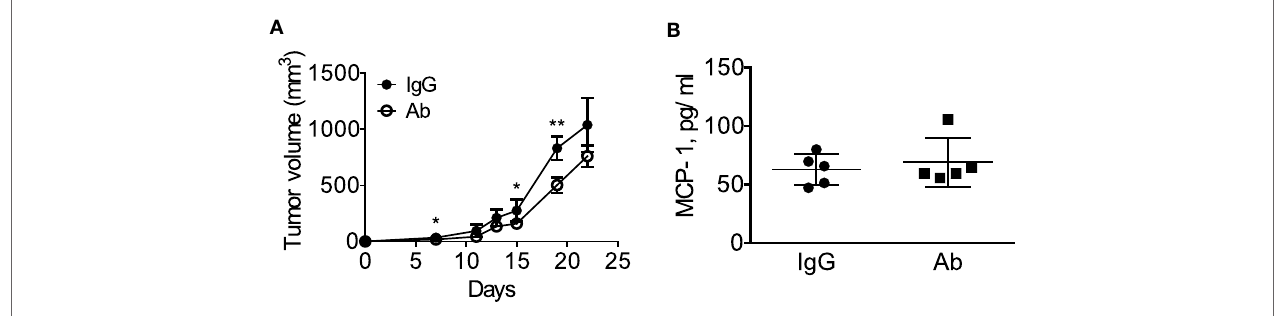
FigUre 7 | intratumoral injection of anti-gM-csF had a limited effect on tumor progression in 4T1 tumor-bearing mice. (a) 1 × 10 5 4T1 cells (100 μ l) were mixed with 10 μ g of normal rat IgG or anti-GM–CSF IgG and injected into the second mammary pad of WT mice. Mice were then received intra-tumor injection of 20 μ g of normal rat IgG or anti-GM-CSF IgG on day 5 and 9, followed by 40 μ g of normal rat IgG or anti-GM-CSF IgG on day 12, 16, and 19. The size of tumor in each mouse was measured and the volume was calculated. The results are shown as the mean ± SD, n = 5, * p < 0.05, ** p < 0.01. (B) Blood was collected by mandibular puncture on day 14, sera were isolated, and MCP-1 concentration was measured by ELISA. The results are shown as the mean ± SEM, n =